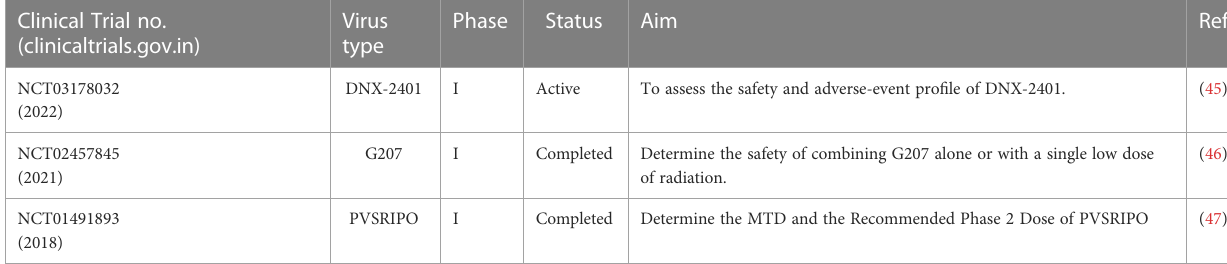
TABLE 2 Major clinical trials reporting the ef fi cacy of oncolytic virus therapy for the treatment of brain tumors. Clinical Trial no.